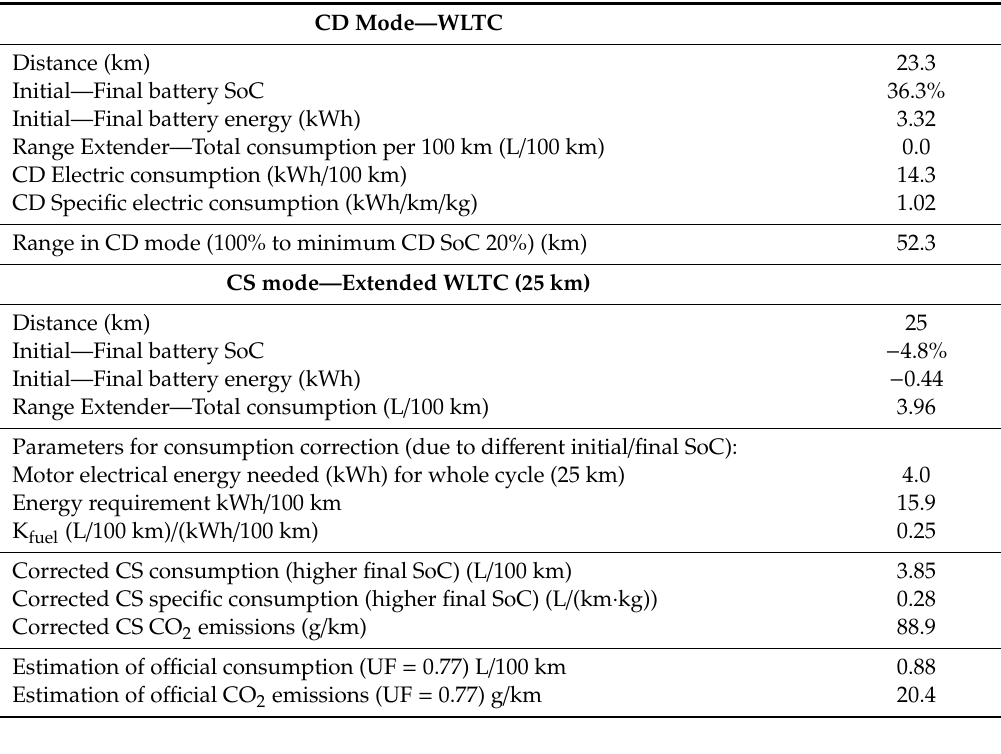
Table 3. Simulation results for charge depleting (CD) and charge sustaining (CS)